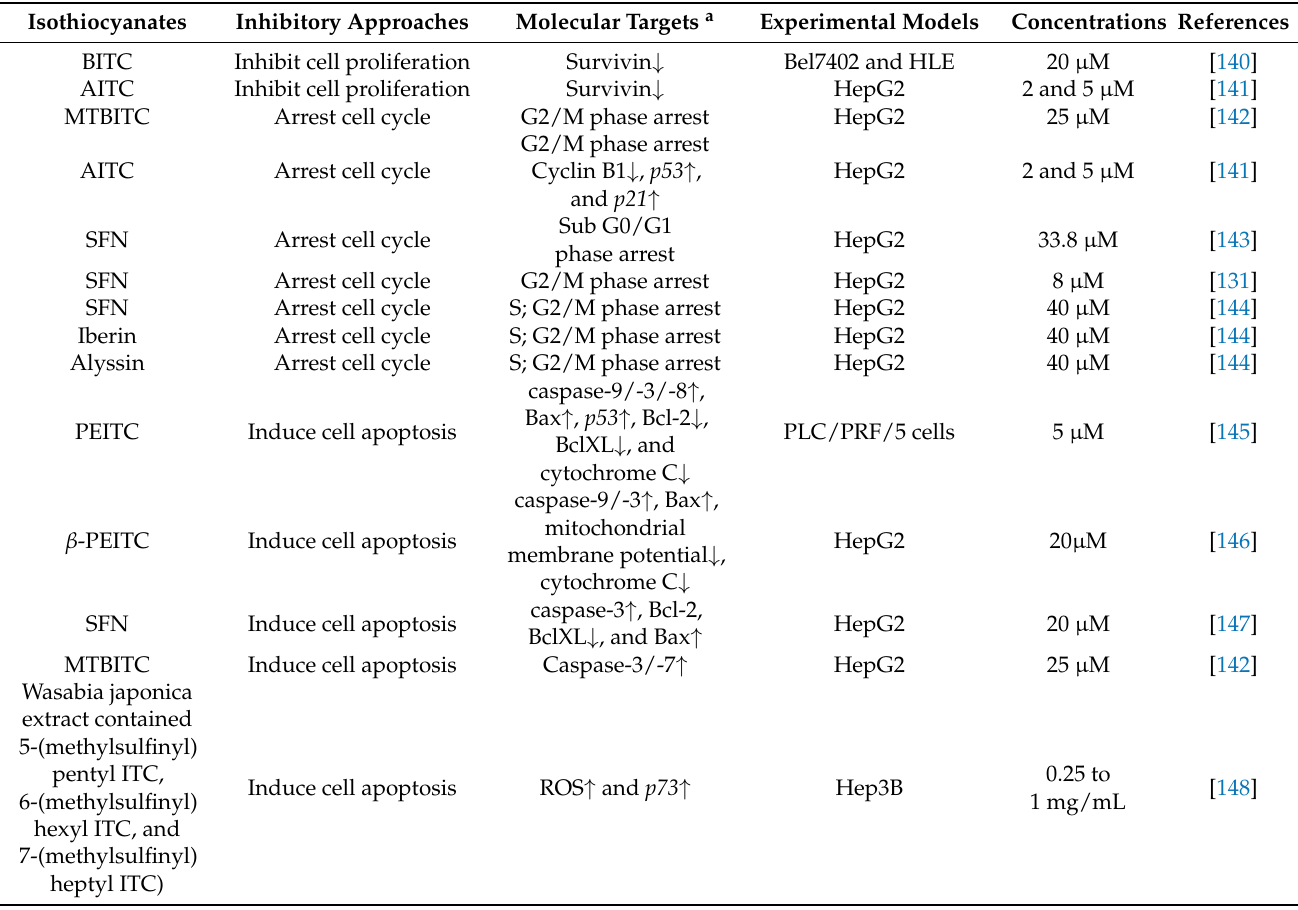
Table 3. Anticancer effects of isothiocyanates on hepatocellular carcinoma and their molecular targets in in vitro and in vivo